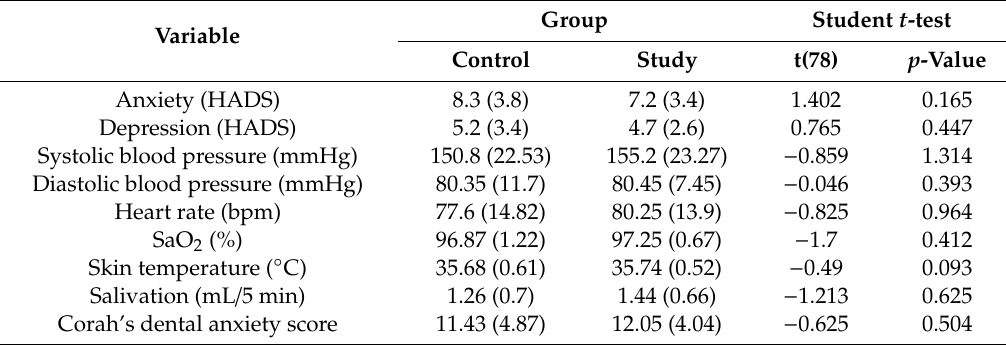
Table 2. Comparison of baseline (pre-consultation) measures between intervention and control